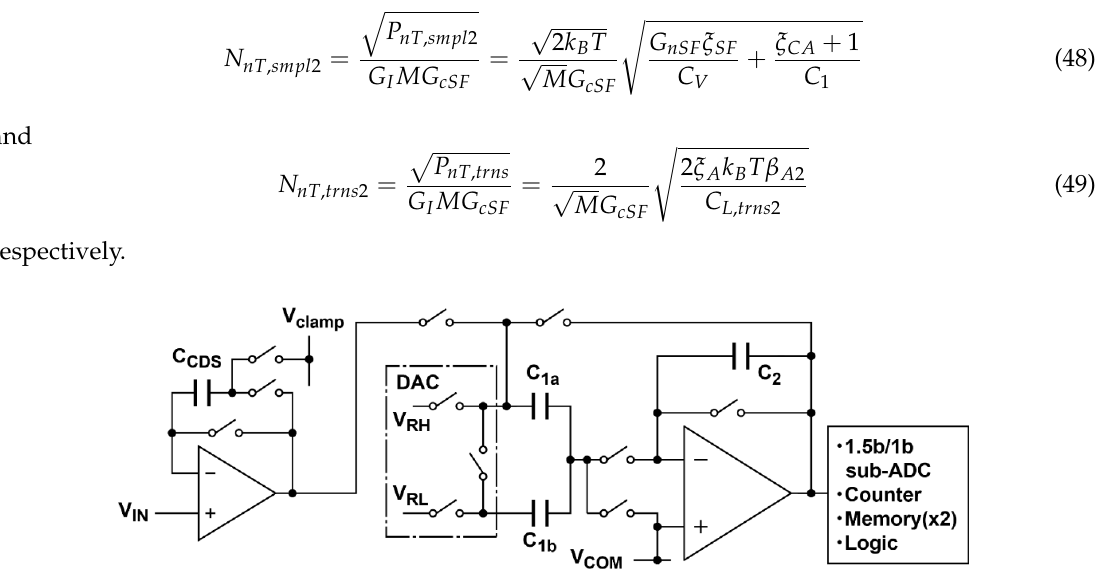
Figure 12. Column analog CDS and ADC circuits.